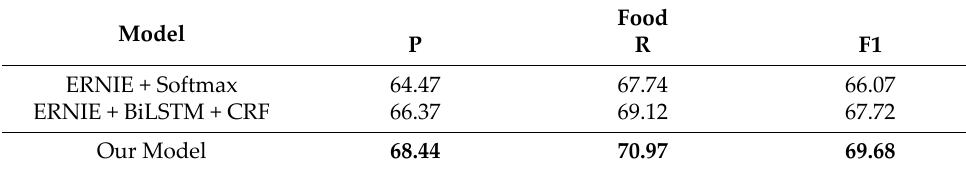
Table 4. Detailed statistics of our model on